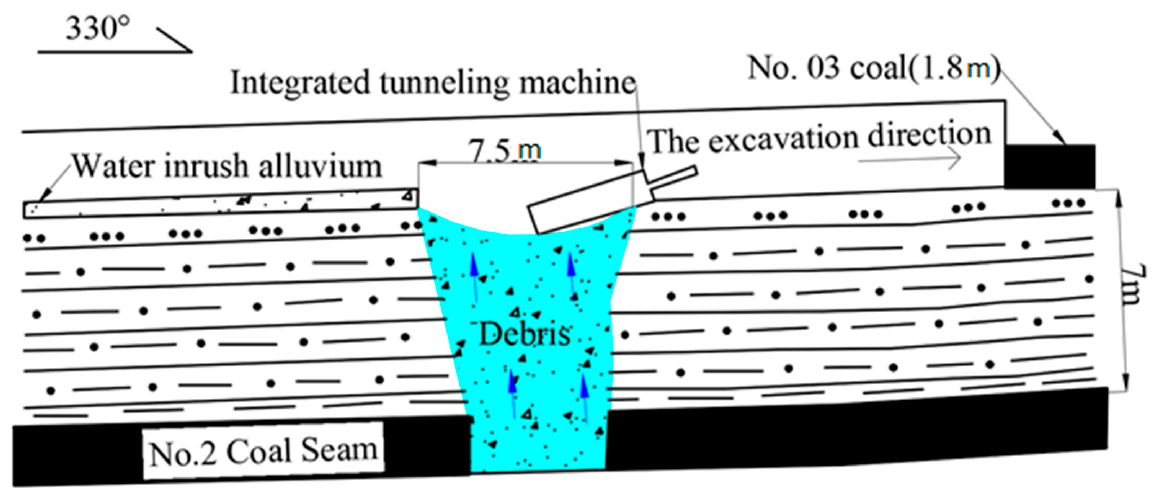
Figure 7. Profile diagram of the water inrush location in the heading direction.